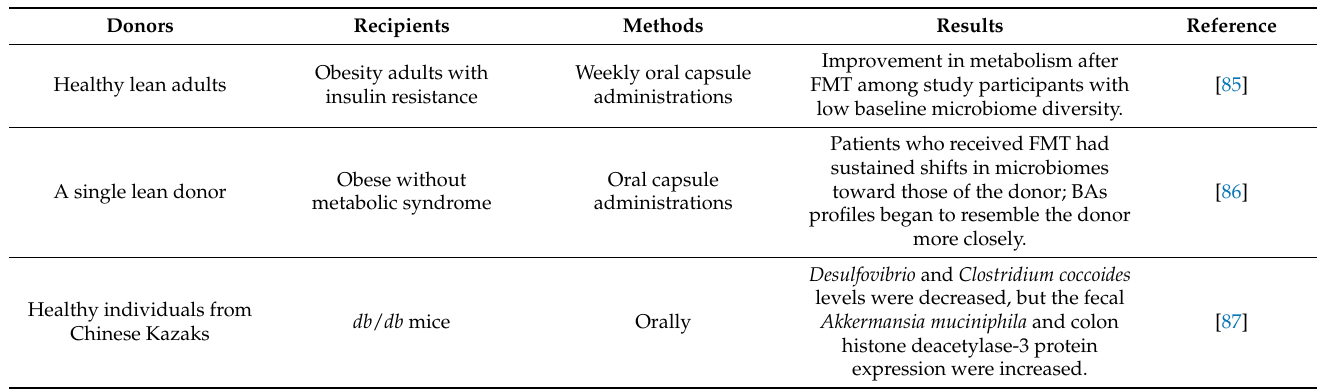
Table 5. Summary of donor, recipients, delivery methods, and results in randomized, controlled trials of FMT for